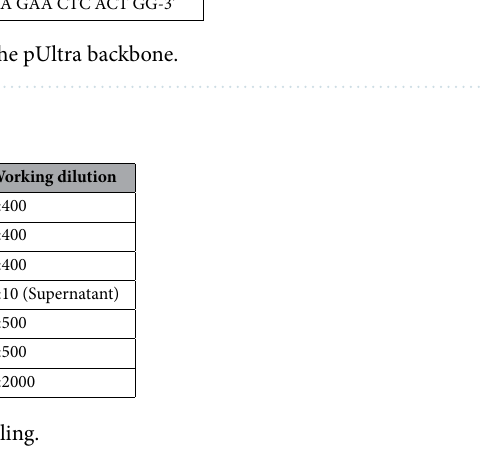
RNA extraction and RT-qPCR analysis. mRNA was isolated from proliferating myoblasts and RH30 cells using the RNeasy kit (Qiagen, 74,104) according to manufacturer’s instructions. mRNA was reverse tran- scribed using the Quantitect reverse transcription kit (Qiagen, 205311) and SYBR green qPCR was performed (Takyon, UF-NSMT-B101), using the Viia7 machine (ThermoFisher). Relative gene expression was normalized to housekeeper RPLP0 , and results are shown as 2 -ΔCT . Primer sequences are: RPLP0 , 5 ′ -TGG TCA TCC AGC AGG